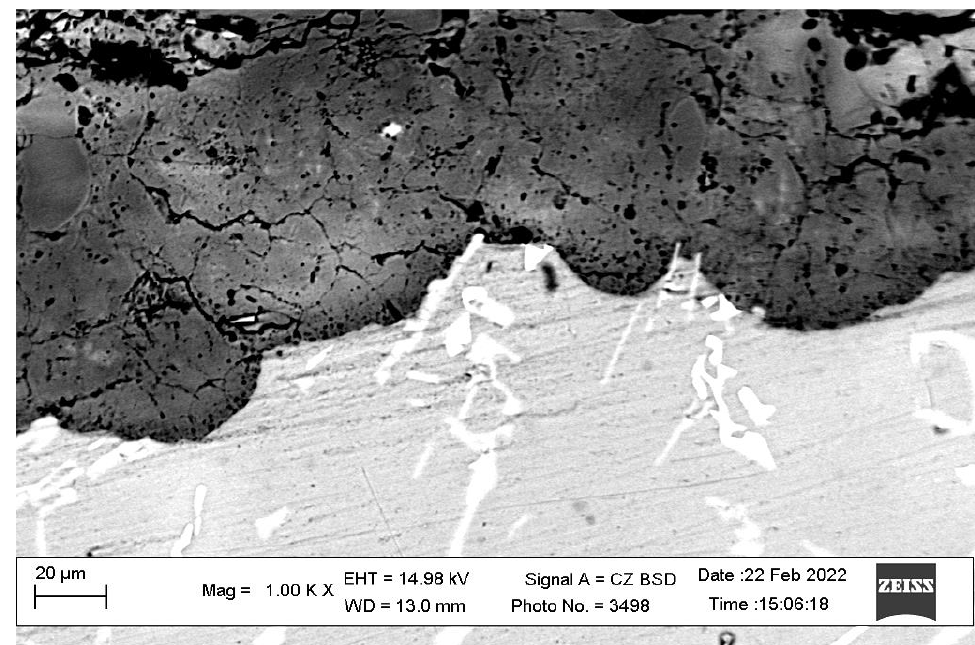
Figure 5. Visualization of the deceleration of the synthesis front of the PEO layer on the AK9 aluminum alloy in the electrolyte of the base composition, which occurred on the silicon crystals encountered on its way.